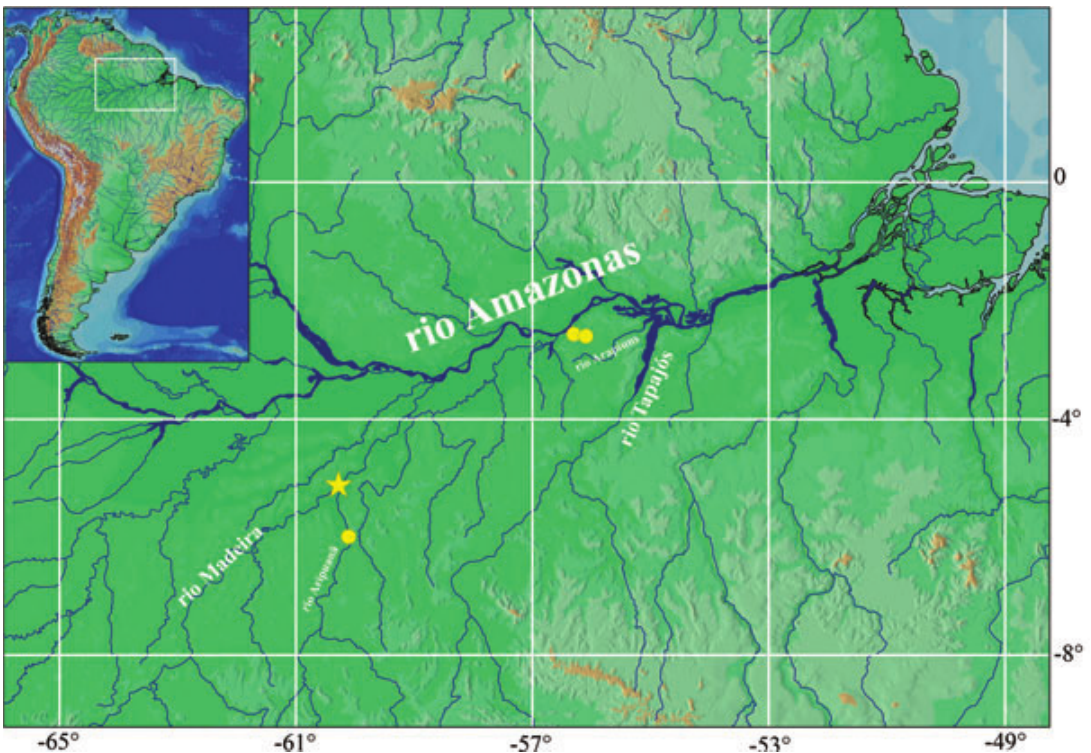
Fig. 5. Map of northern South America showing the distribution of Trichomycterus anhanga . A star indicates the type